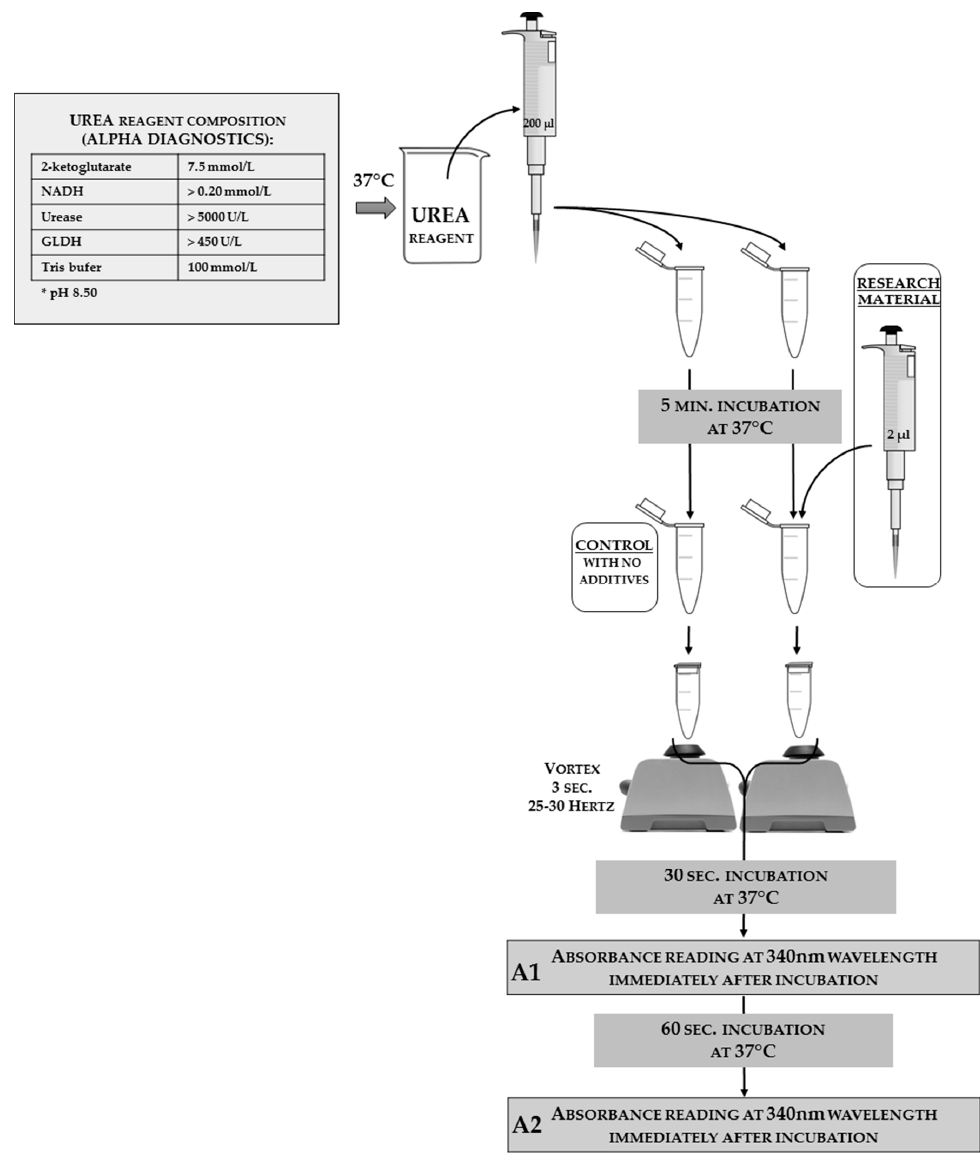
Figure 13. The scheme of urea concentration analysis adjusted for insect hemolymph solutions with